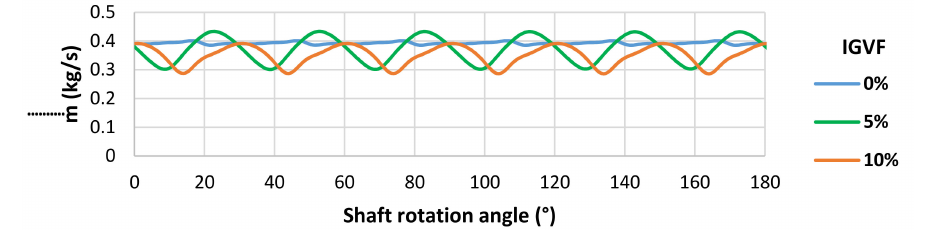
Figure 30. Outlet mass flow ripple CFD data for the BVP at p 2 = 5 bar pressure load, 20 ◦ C oil temperature and 2000 rpm at different IGVF.